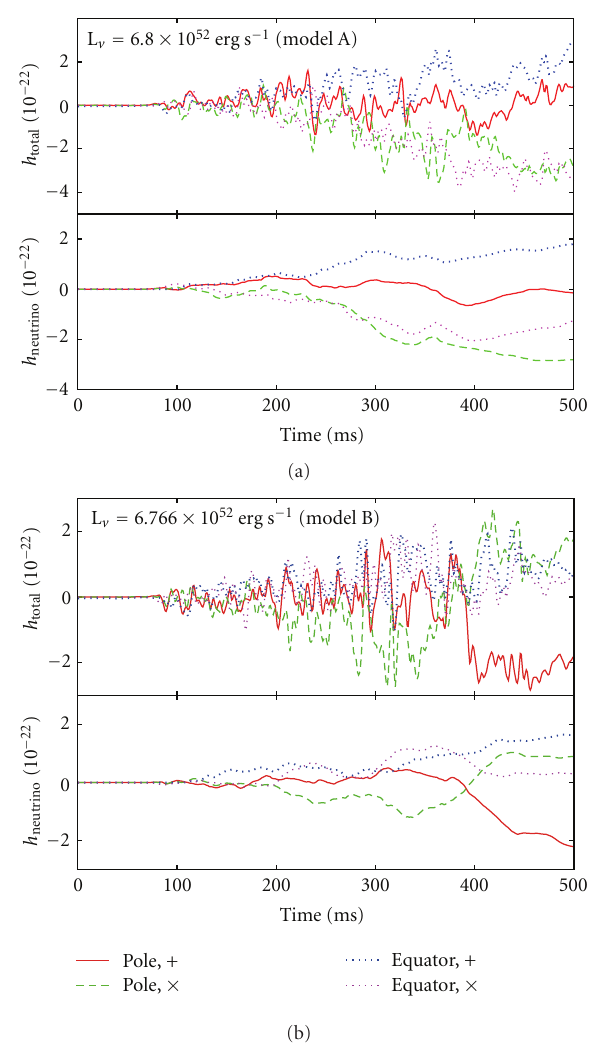
Figure 10: Gravitational waveforms from neutrinos (bottom) and from the sum of neutrinos and matter motions (top), seen from the polar axis and along the equator (indicated by “Pole” and “Equator”) with polarization (+ or × modes) for two representative 3D models of A and B (see [194] for details). The distance to the SN is assumed to be 10